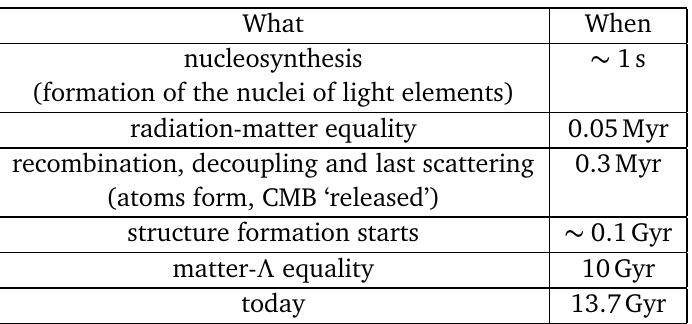
Table 1: Summary of the history of